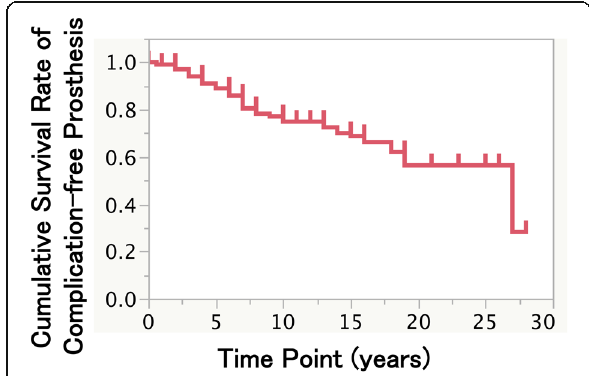
Fig. 5 Kaplan-Meier cumulative survival rate of complication-free prostheses at 10, 15, and 25 years after the prosthesis